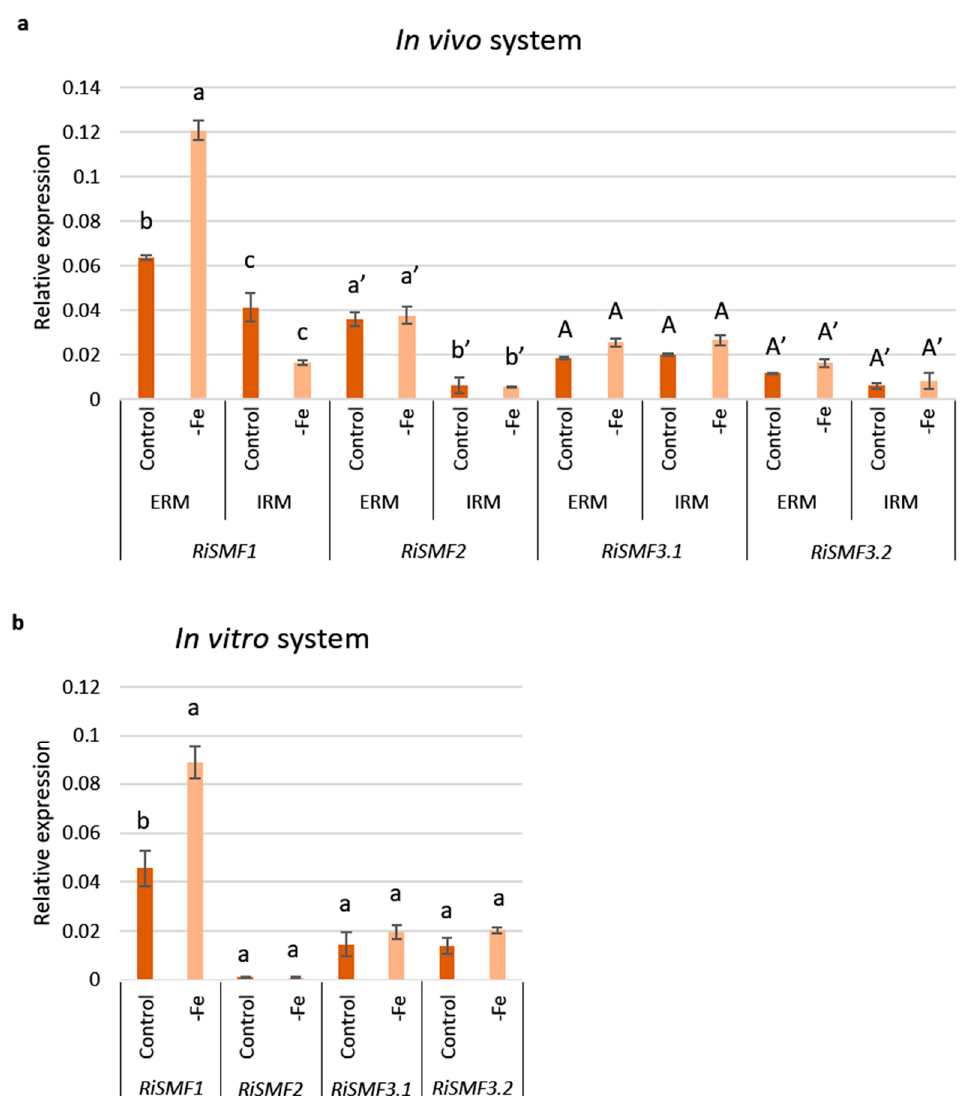
Figure 7. Effect of Fe deficiency on RiSMF s expression. ( a ) Gene expression was analysed in RNAs isolated from mycorrhizal roots (IRM) and ERM collected from chicory plants developed in the whole plant bidimensional culture system (in vivo system) watered with half-strength Hoagland solution (control, 50 µ M Fe) or a modified nutrient solution without Fe (-Fe). ( b ) Gene expression was analysed in RNAs isolated from ERM developed in monoxenic cultures ( in vitro system) in liquid M media lacking Fe and exposed 3 days to 0.5 mM ferrozine (-Fe) or in M medium containing 45 µ M Fe (control). Relative gene expression levels were calculated using the 2 − ∆ CT method with RiEF1 α as internal control. Bars represent standard error. Different type letters indicate statistical data for each gene. Different letters indicate significant differences ( p < 0.05; n = 3) between treatments.